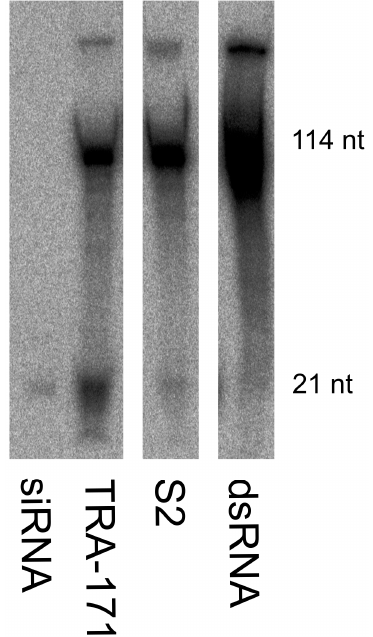
Figure 2. Production of small RNAs from long dsRNA. The cellular extracts were prepared from TRA-171 and S2 cells. The extracts were incubated with 32 P internally-labeled dsRNA (114 nt). Size markers of long dsRNA (114 nt) and siRNAs (21 nt) are indicated to show approximate sizes. The image shown is representative of three independent experiments and shows relevant individual lanes. The complete image is shown in Supplementary Figure S1.